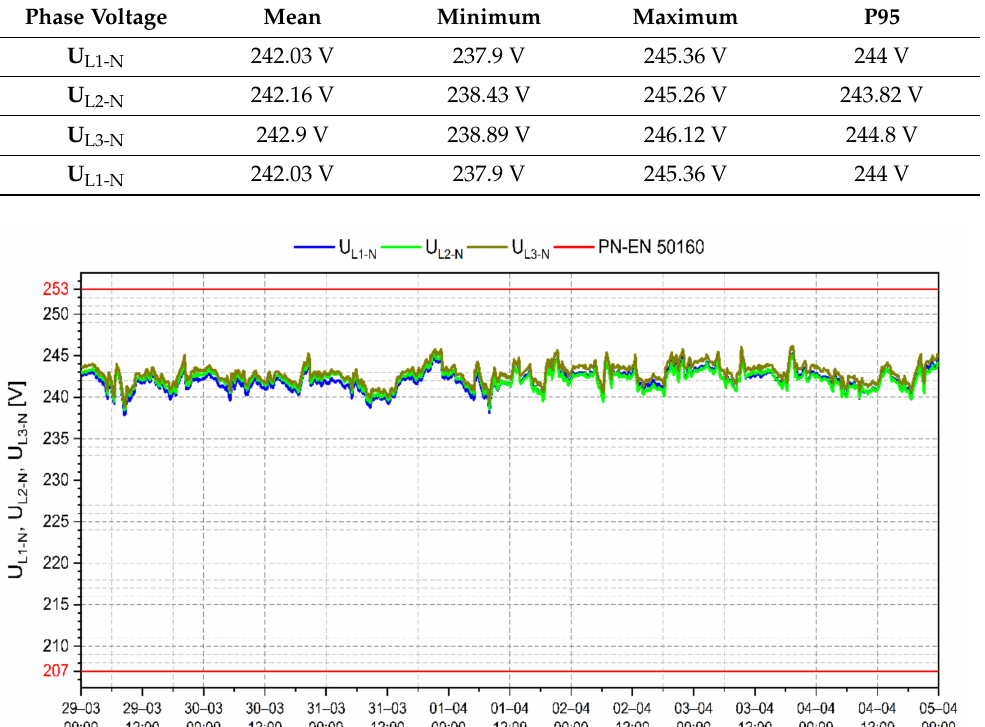
Figure 6. Phase voltage variation during the measurement